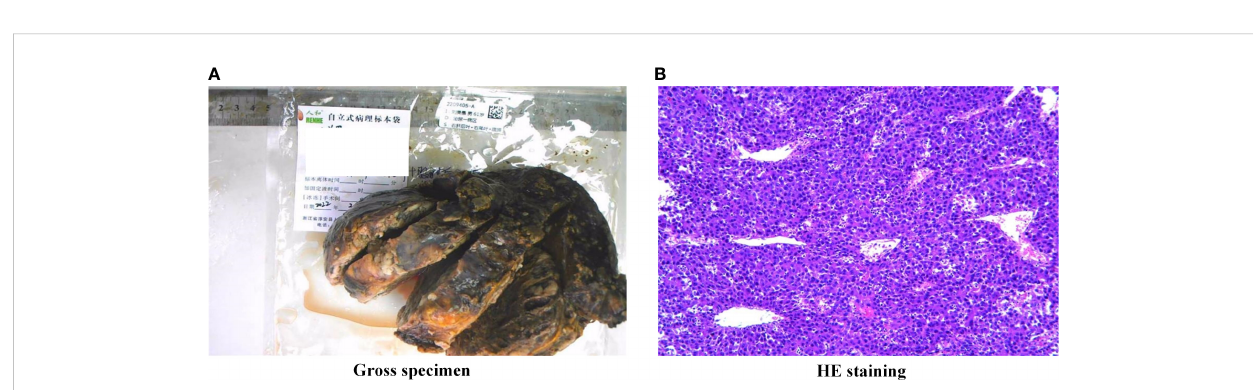
FIGURE 2 Gross specimen and HE staining. (A) Macroscopic features of the excised hepatocellular carcinoma demonstrating a solid tumor with a fi brous capsule and intratumoral hemorrhage, (B) HE staining of the tumor con fi rmed poorly differentiated carcinoma morphologically, magni fi cation × 100. The hepatoma cells were large, polygonal, rich in cytoplasm and red staining, and were diagnosed as massive beam and cord liver